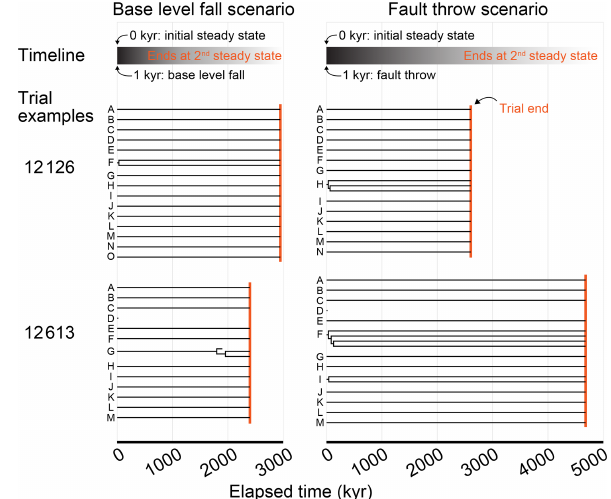
Figure 12. Phylogeny of exemplary trials. Topography was per- turbed by base-level fall of fault throw at 1kyr elapsed since the first steady state was reached. Most of the trials animated in the “Video supplement” are shown. Trial 5043 is not included. Species did not change in this trial because no stream networks disappeared or were captured. The lineages of clades in a trial are labelled alphabeti- cally. Speciation events occurred when lineages split and extinction occurred when lineages terminated before the end of the